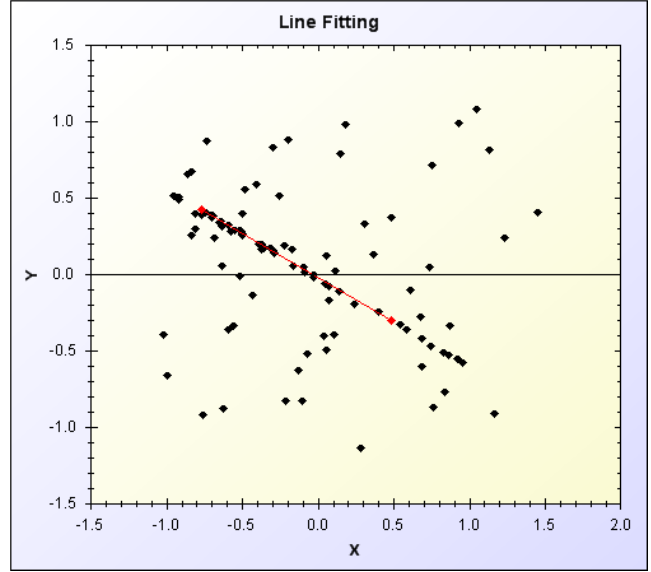
Figure 2. Simple line fitting by parameter